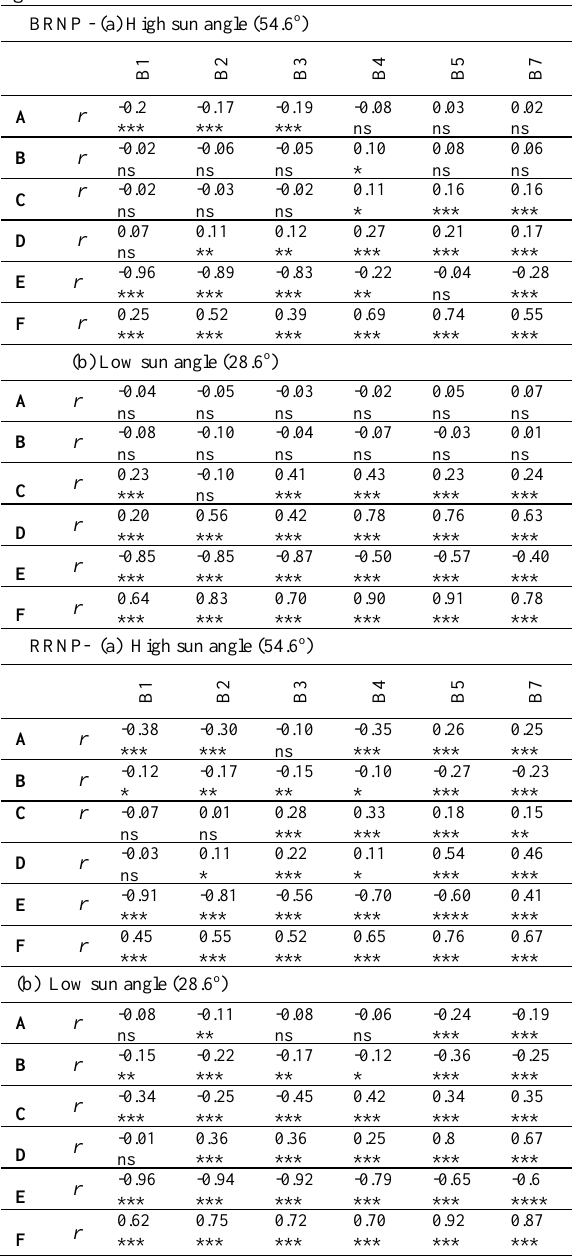
Figure 4 and 5 illustrate relationships between field measured overstorey FPC estimates, and high and low sun angle TM5 data predicted overstorey FPC estimates, after the application of the topographic corrections. It is observed that the PSSSR applied to high sun angle data shows a strong relationship ( r 2 -51) between filed measured FPC and TM5 predicted FPC in both study sites, where as SCS correction provides a weak relationship ( r 2 -13).